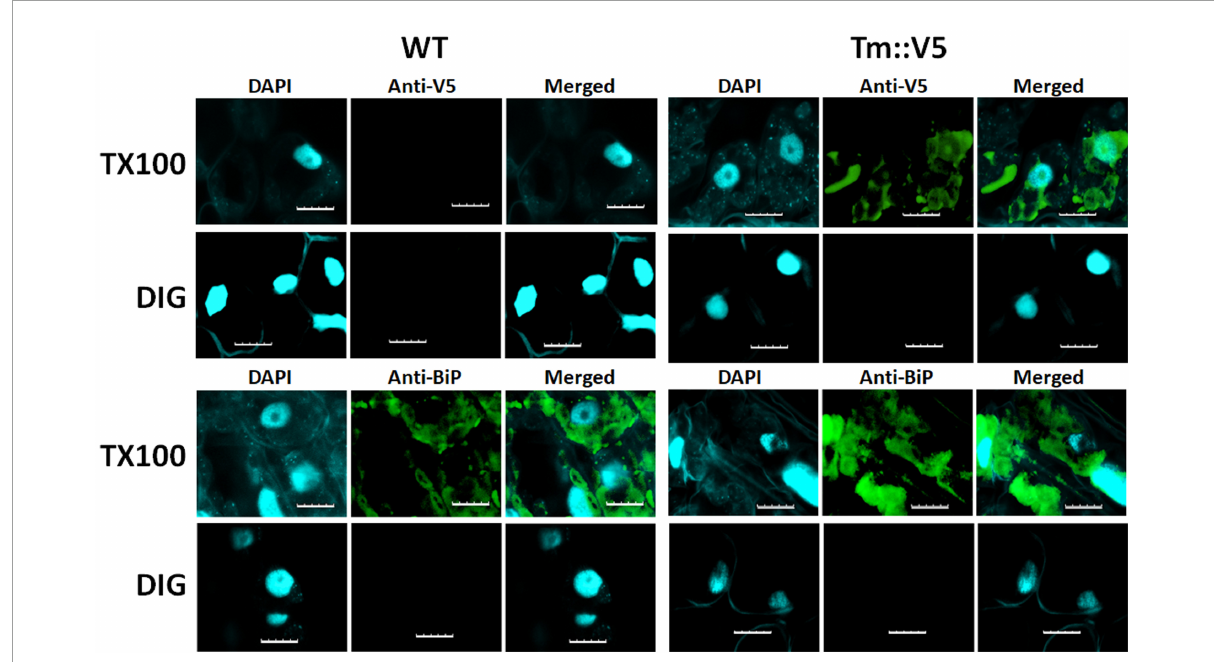
FIGURE7 Differential permeabilization analysis of L. perenne cells expressing Tm DGAT1. Nuclei of individual cells of wild-type (WT) and cells expressing C-terminally V5 tagged recombinant T. majus DGAT1 (Tm::V5) were visualized by DAPI stain. Cells were permeabilized with either digitonin (DIG) or triton X-100 (TX100) then probed with antibodies raised against either V5 or Bip, followed by the appropriate secondary antibody. No V5 or Bip signal was detected when cells were permeabilized with DIG. However, both V5 and Bip were detected in cells expressing Tm after they were permeabilized with TX100 indicating the C-terminus of Tm DGAT1 is located in the membrane compartment. Scale bar = 10 µ